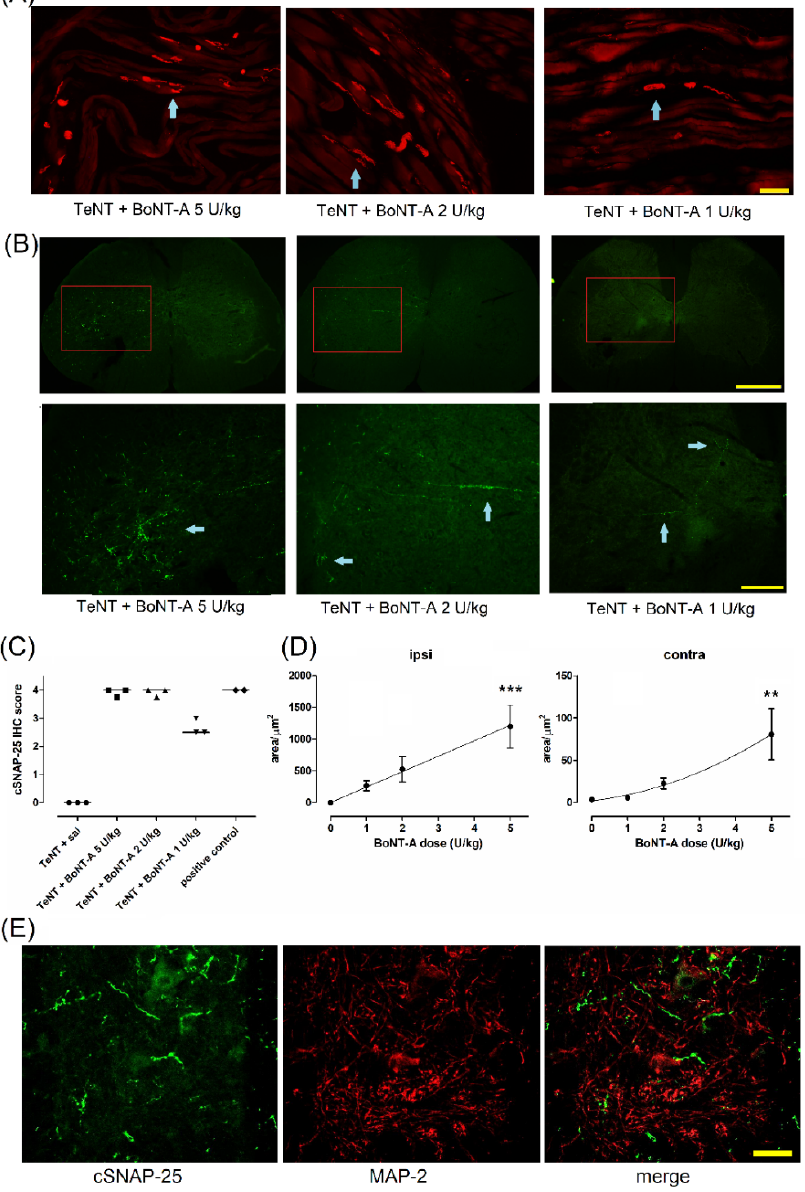
Figure 5. Enzymatic product of BoNT-A in the muscle and spinal cord persists for more than 2 months post-BoNT-A i.m. treatments. BoNT-A (1–5 U/kg) was injected into the gastrocnemius muscle, and the presence of BoNT-A-cleaved SNAP-25 (cSNAP-25) was examined in the injected muscle ( A ) and spinal cord ( B ) on day 71 post-toxin treatment. ( A ) Red immunoreactivity shows neuromuscular junctions and nerve terminals (cyan arrow; scale bar = 100 µ m). ( B ) Upper and lower-panel microphotographs indicate the low (2 × ) and higher (5 × ) magnification images of the same representative L4 spinal cord sections with green immunoreactivity indicating cSNAP (arrow) (scale bars = 500 µ m and 200 µ m, respectively). The scoring method suggests an abundant presence of neuromuscular junctions, nerve terminals or axons immunoreactive for cleaved SNAP-25 in BoNT- A-treated muscle at more than 2 months post-BoNT-A (N = 3 animals per group, 4 visual fields per animal each taken from different section), as well as in 2 positive controls (obtained from the